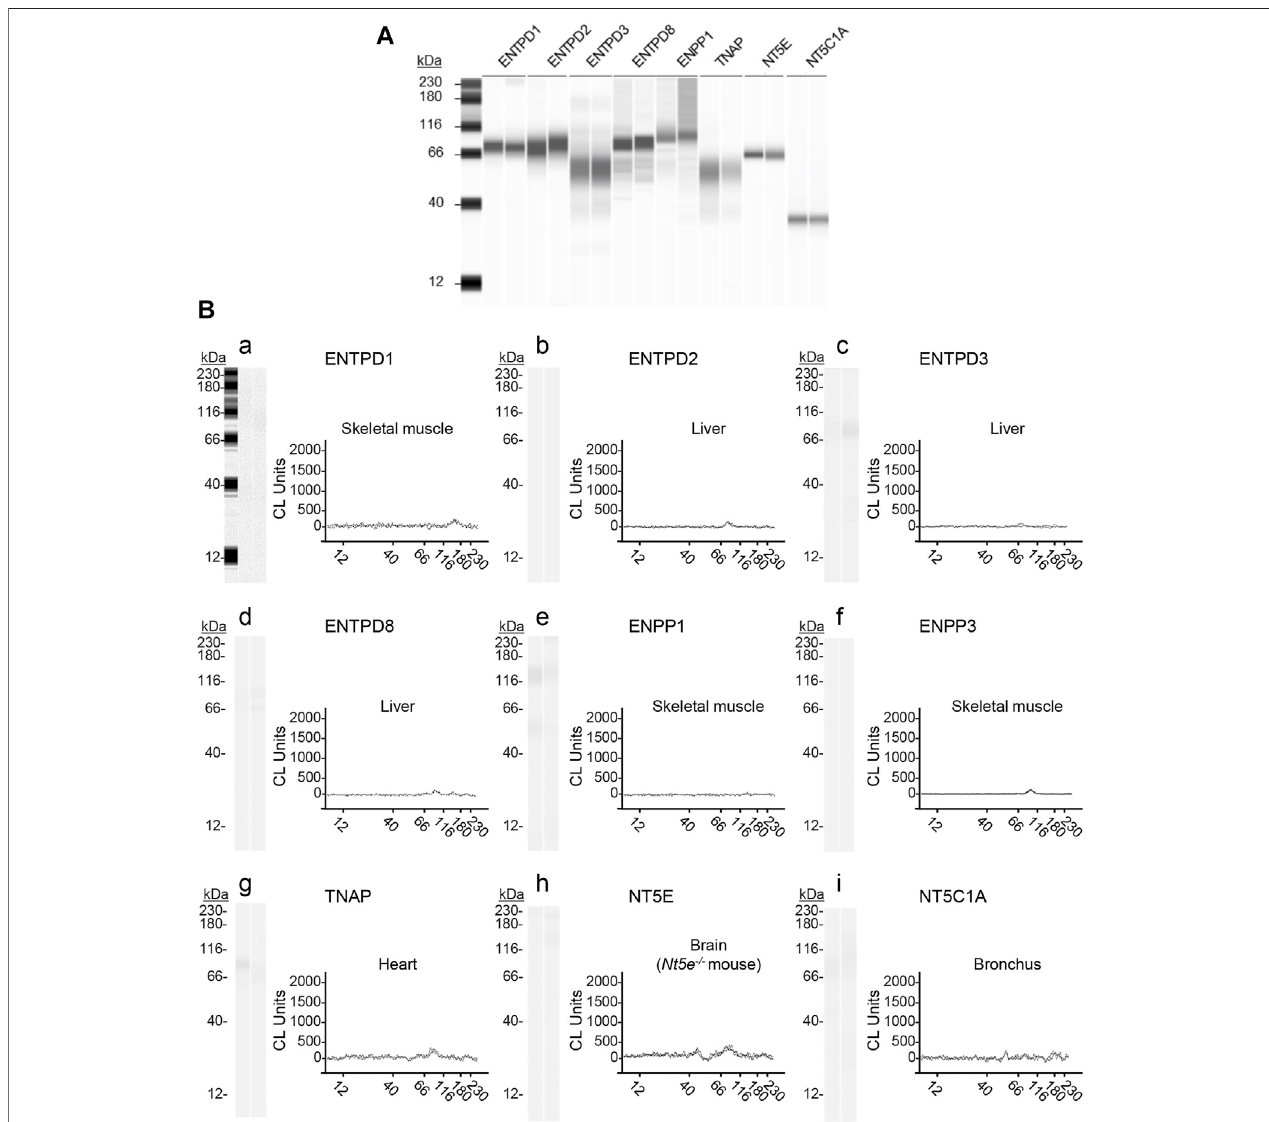
FIGURE9| Validationofanti-nucleotidaseantibodiesusedforenzymeidenti fi cation.ProteinSimpleWeswasusedtospeci fi callydetecttheindicatednucleotidases in (A) mousebrainhomogenates(positive controls)andin (B) mousetissuehomogenatesinwhichtheindicatednucleotidasehasnotbeendetected (negativecontrols). Panel (Ba – Bi) show representative blot images (left) and immunoelectropherograms (right) of negative control tissue homogenates. Each antibody was tested in duplicate.Theantibodies,dilutions,correspondingamountsofhomogenateperwell,andexpectedmolecularweight(fromvendor)usedwere:rabbitanti-ENTPD1 (1:200, 15 μ g, and 80 kDa), sheep anti-ENTPD2 (1:500, 7.5 µg, and 80 kDa); rabbit anti-ENTPD3 (1:500, 3.0 µg, and 80 kDa); rabbit anti-ENTPD8 (1:200, 15 μ g, and 60 kDa);rabbitanti-ENPP1(1:500,15 μ g,and100 kDa);rabbitanti-ENPP3(1:500,15 μ g,and100 kDa);rabbitanti-NT5E(1:500,15 μ g,7and0 kDa);rabbitanti-TNAP (1:200, 30 μ g, and 60 kDa; rabbit anti-NT5C1A (1:100, 30 μ g, and 40 kDa)).